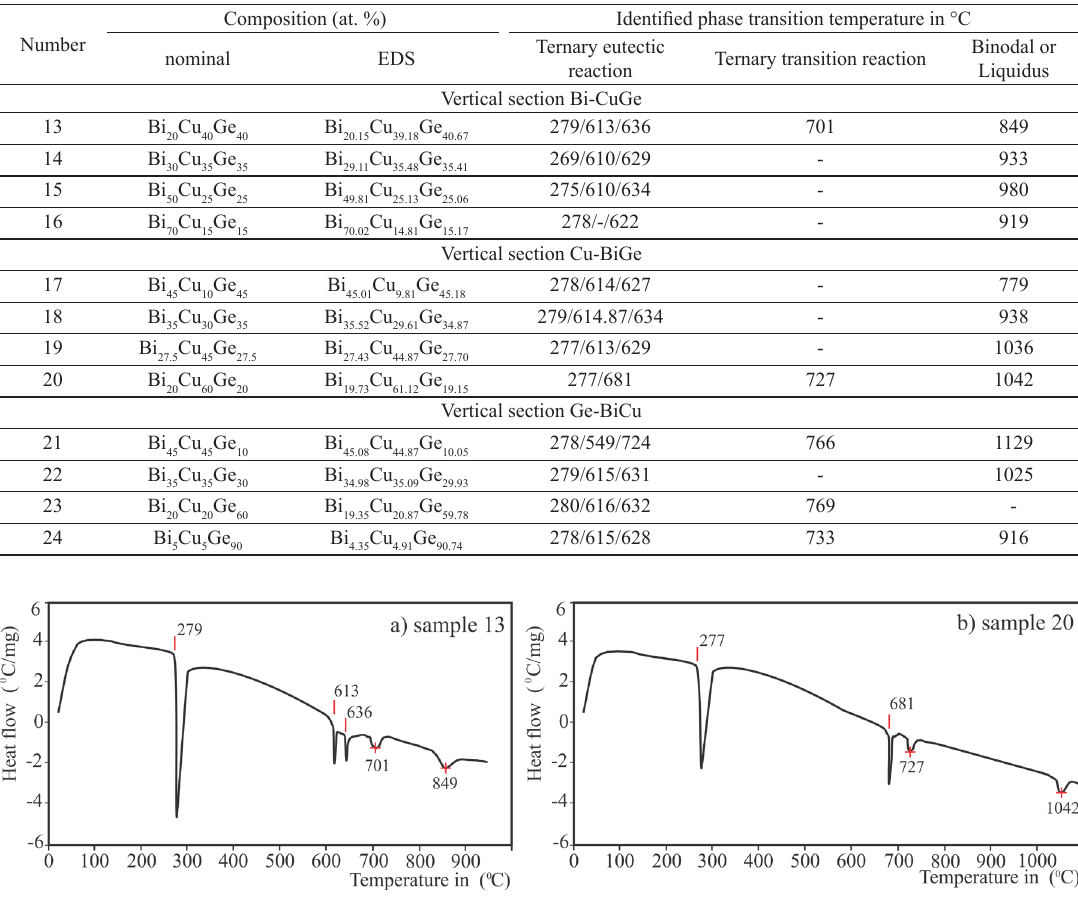
Figure 8. DTA heating curve of samples 13 and 20.